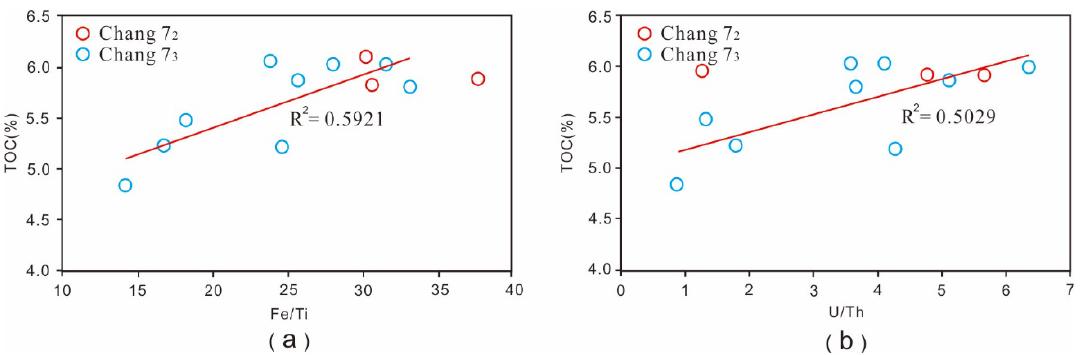
Figure 8. The cross-plot of volcanism and hydrothermal activity indexes and TOC: ( a ) relationship between Fe/Ti and TOC; ( b ) relationship between U/Th and TOC.